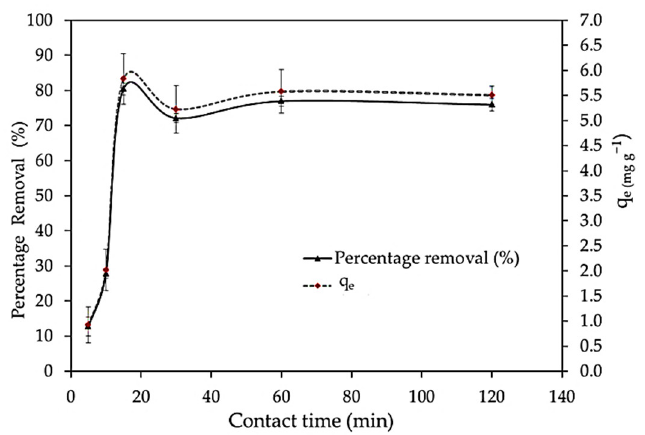
Figure 8. Impact of different contact times on adsorption percentages of the methylene blue dye.